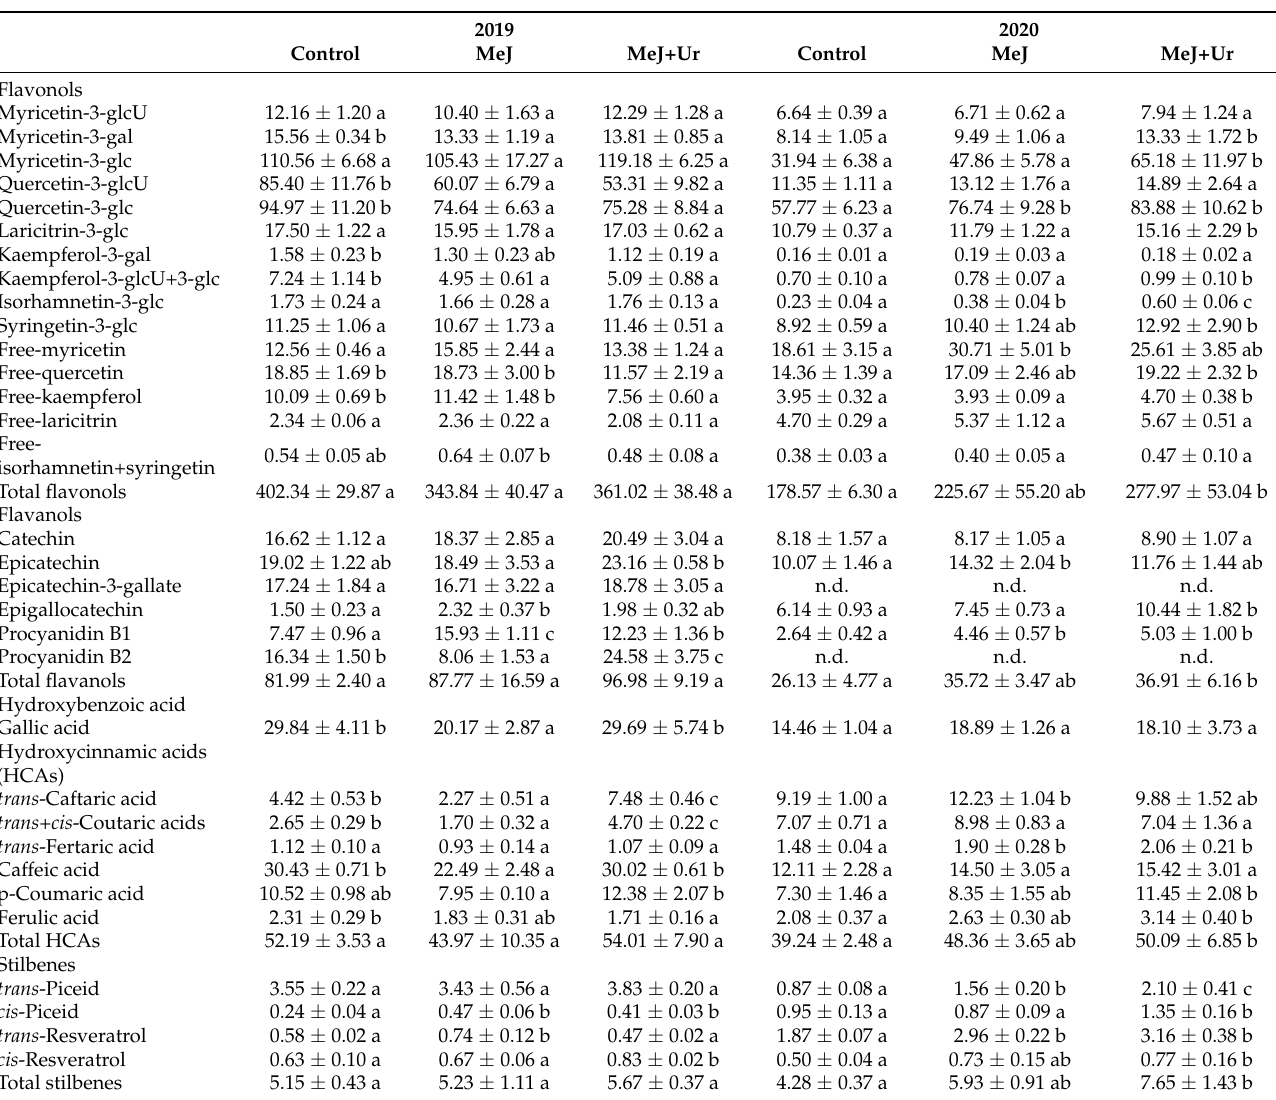
Table 3. Flavonol, flavanol, phenolic acid and stilbene content (mg/L) in wines from control, methyl jasmonate (MeJ) and MeJ+Urea (MeJ+Ur) treatments, in seasons from 2019 and